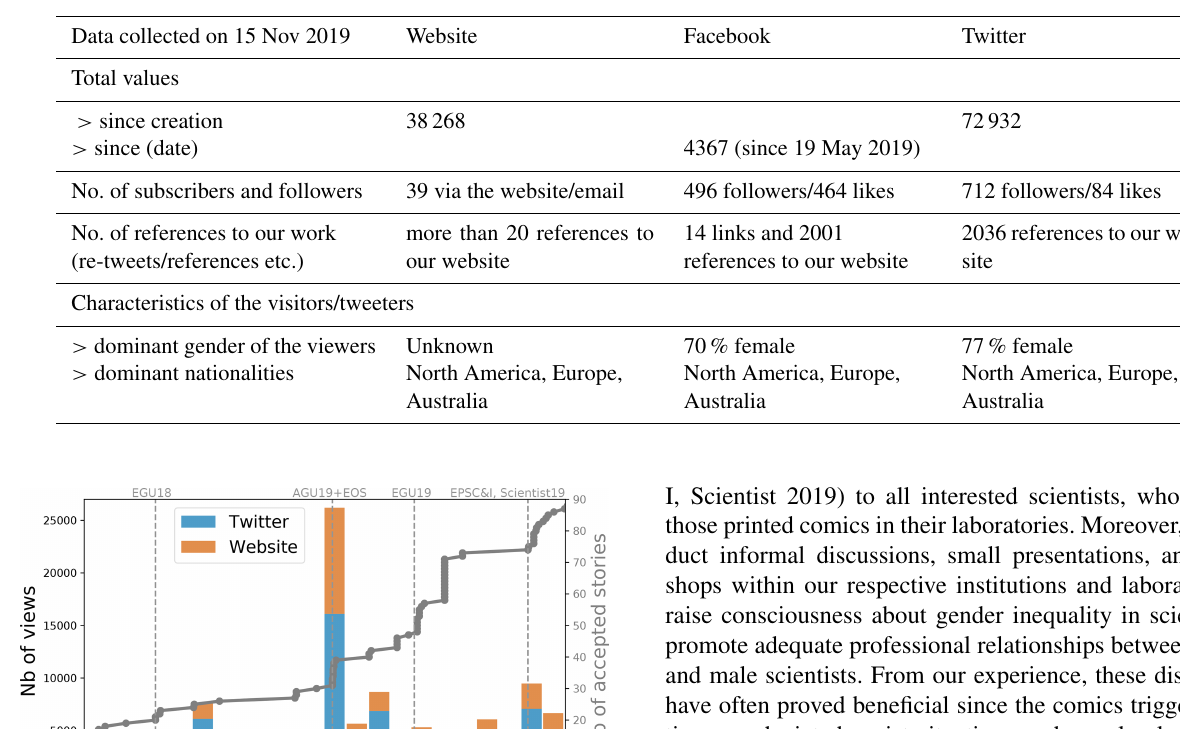
Table 1. Statistics on our web-based presence.